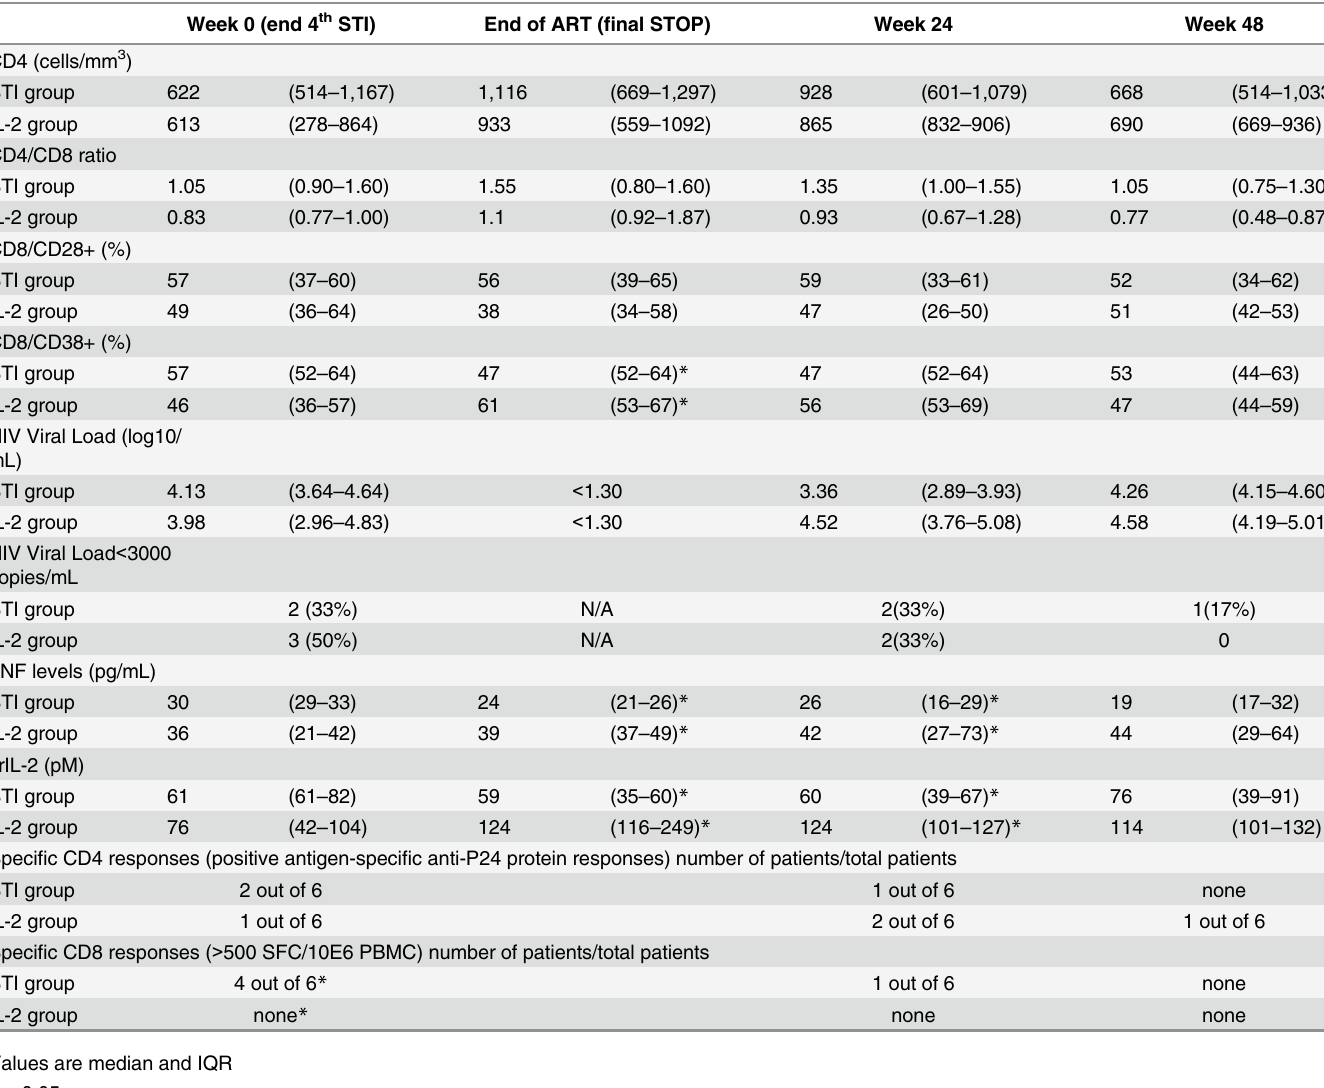
Table 2. Inflammation, immune activation, immunological and virological evolution following the end of 4 th STI (week 0) until week 48 of follow-up. Week 0 (end 4 th STI) End of ART ( fi nal